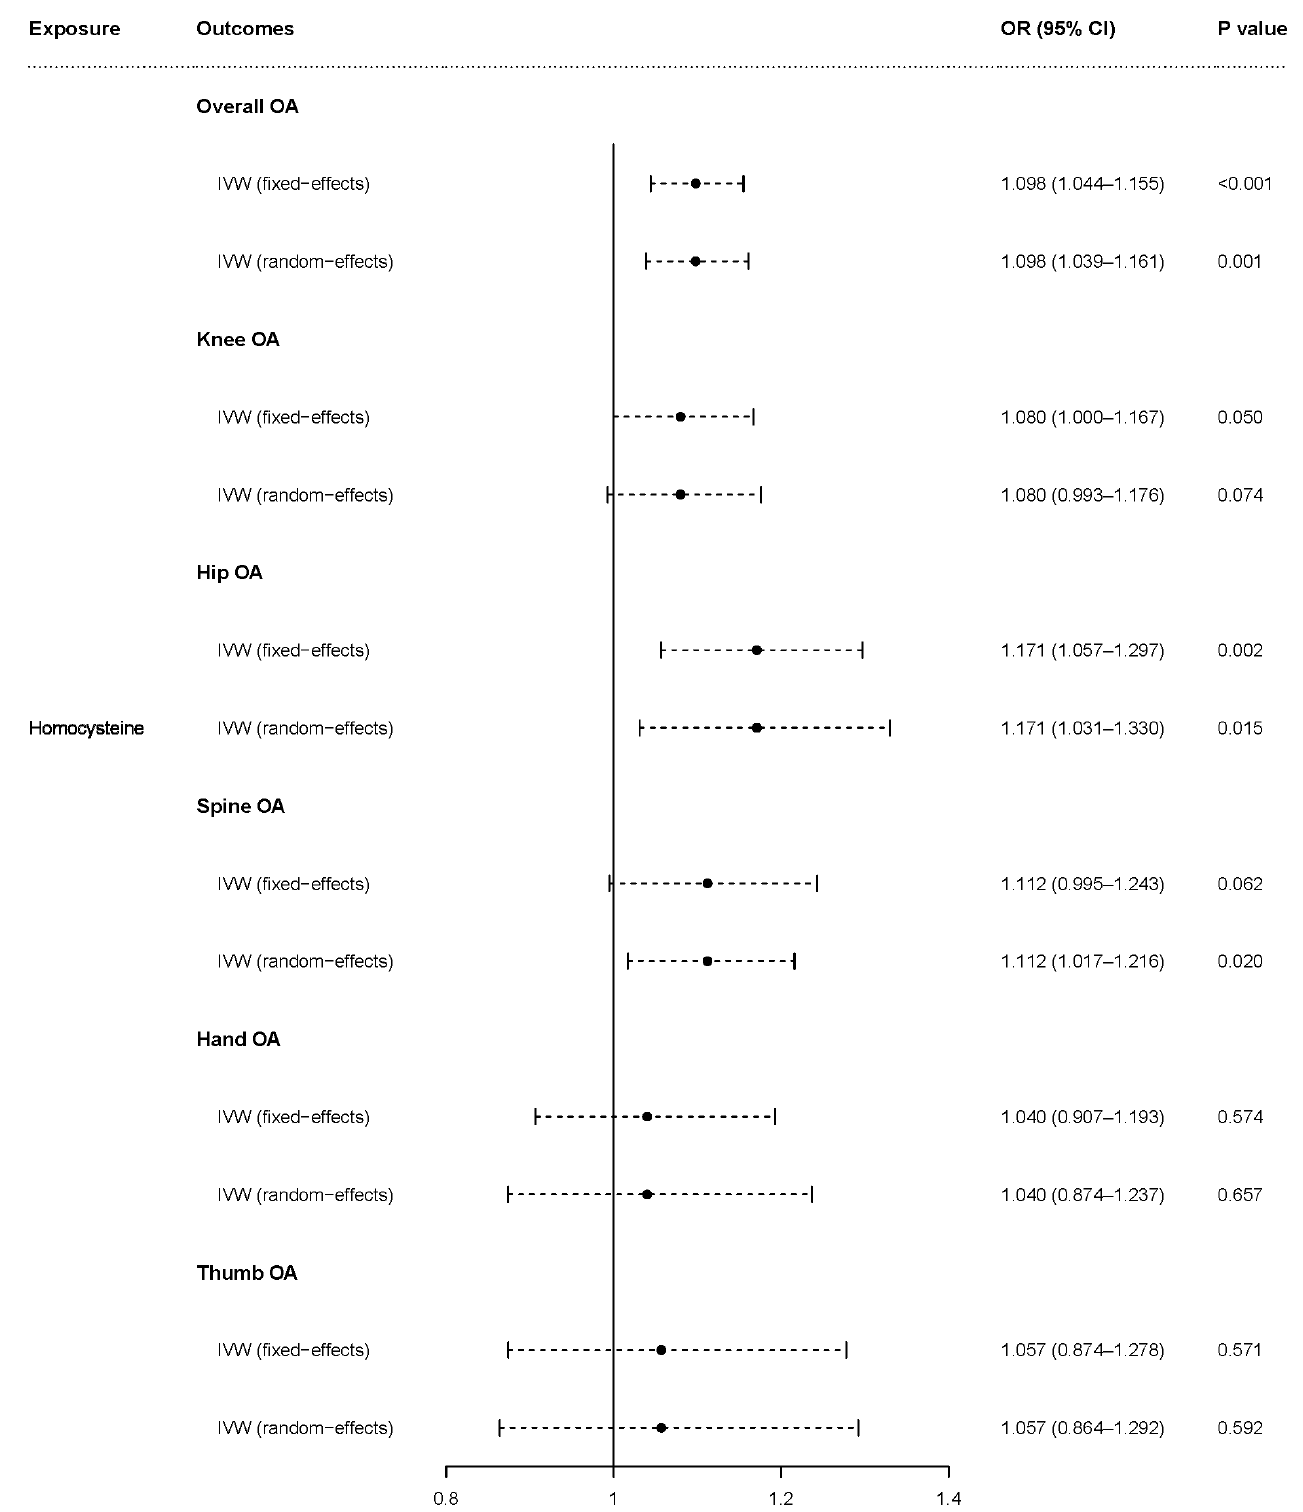
Figure 2. Causal effect of homocysteine on OA and subtypes in fixed-effects and random-effects IVW analyses. OR: odds ratio; CI: confidence interval; p value: p value of the causal estimate.